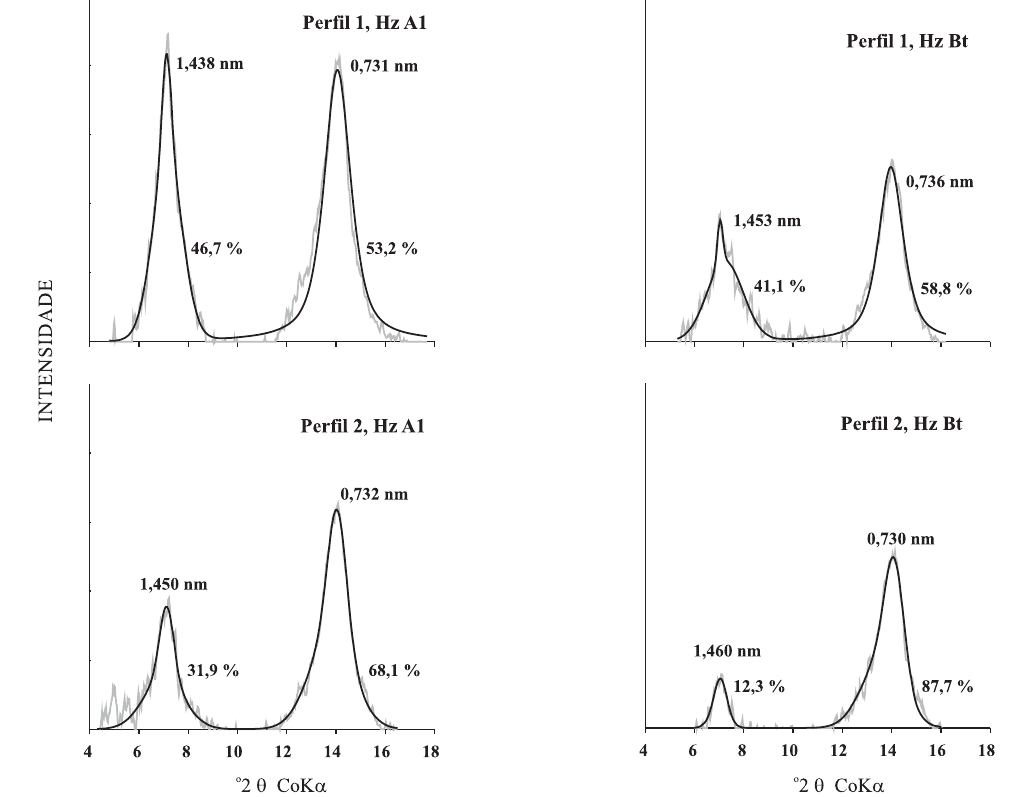
Figura 4. Difratogramas de raios X (25 °C) entre os ângulos 4 e 18 o de 2 θθθθθ após modelagem matemática com DecompXR, obtidos a partir de amostras da fração menor que 0,2 (cid:122) m, saturadas ao Ca 2+ do horizonte A1 e Bt de um Argissolo Vermelho-Amarelo distrófico, perfil 1, localizado em meia encosta sob campo nativo e perfil 2 em topo de coxilha sob vegetação pioneira. A linha cheia clara ( experimental do DRX, a linha cheia escura